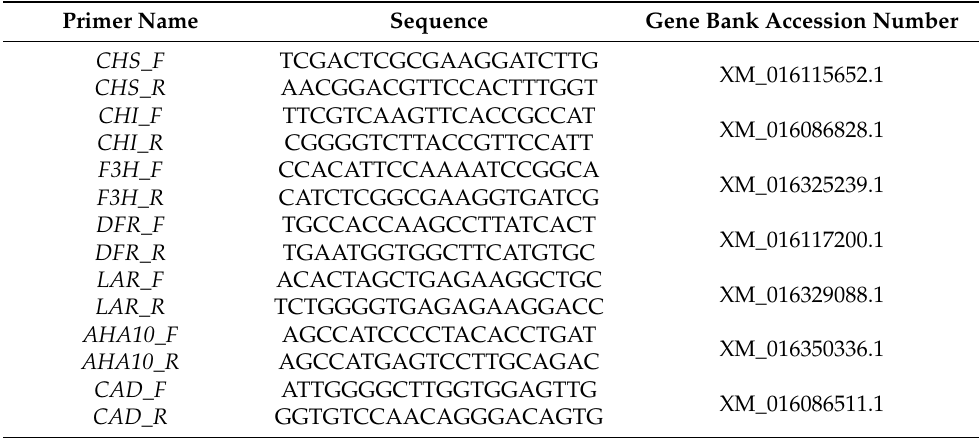
Table 3. List of primers used for gene expression analysis of lignin- and tannin-related genes in peanut seed